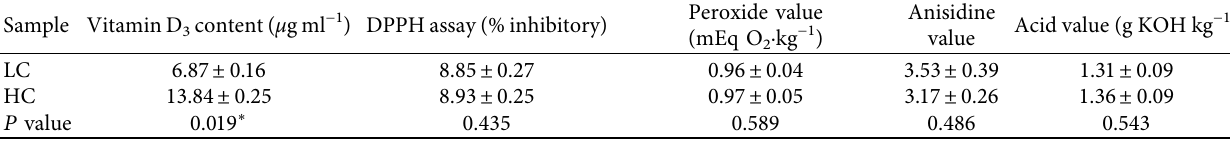
Table 1: Initial characteristics of the oil